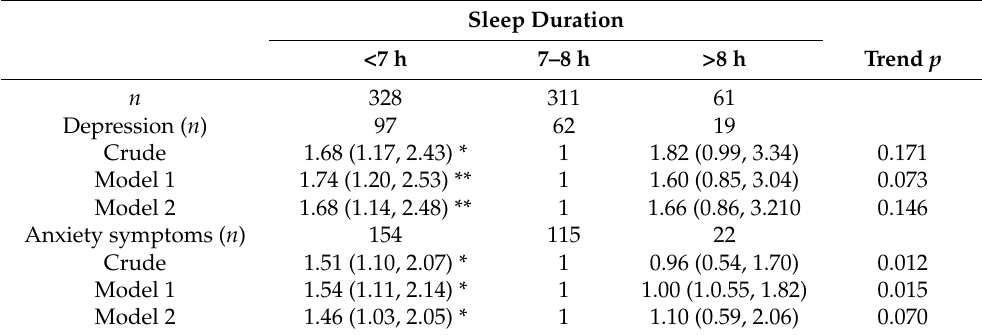
Table 2. Adjusted association between sleep duration and mental